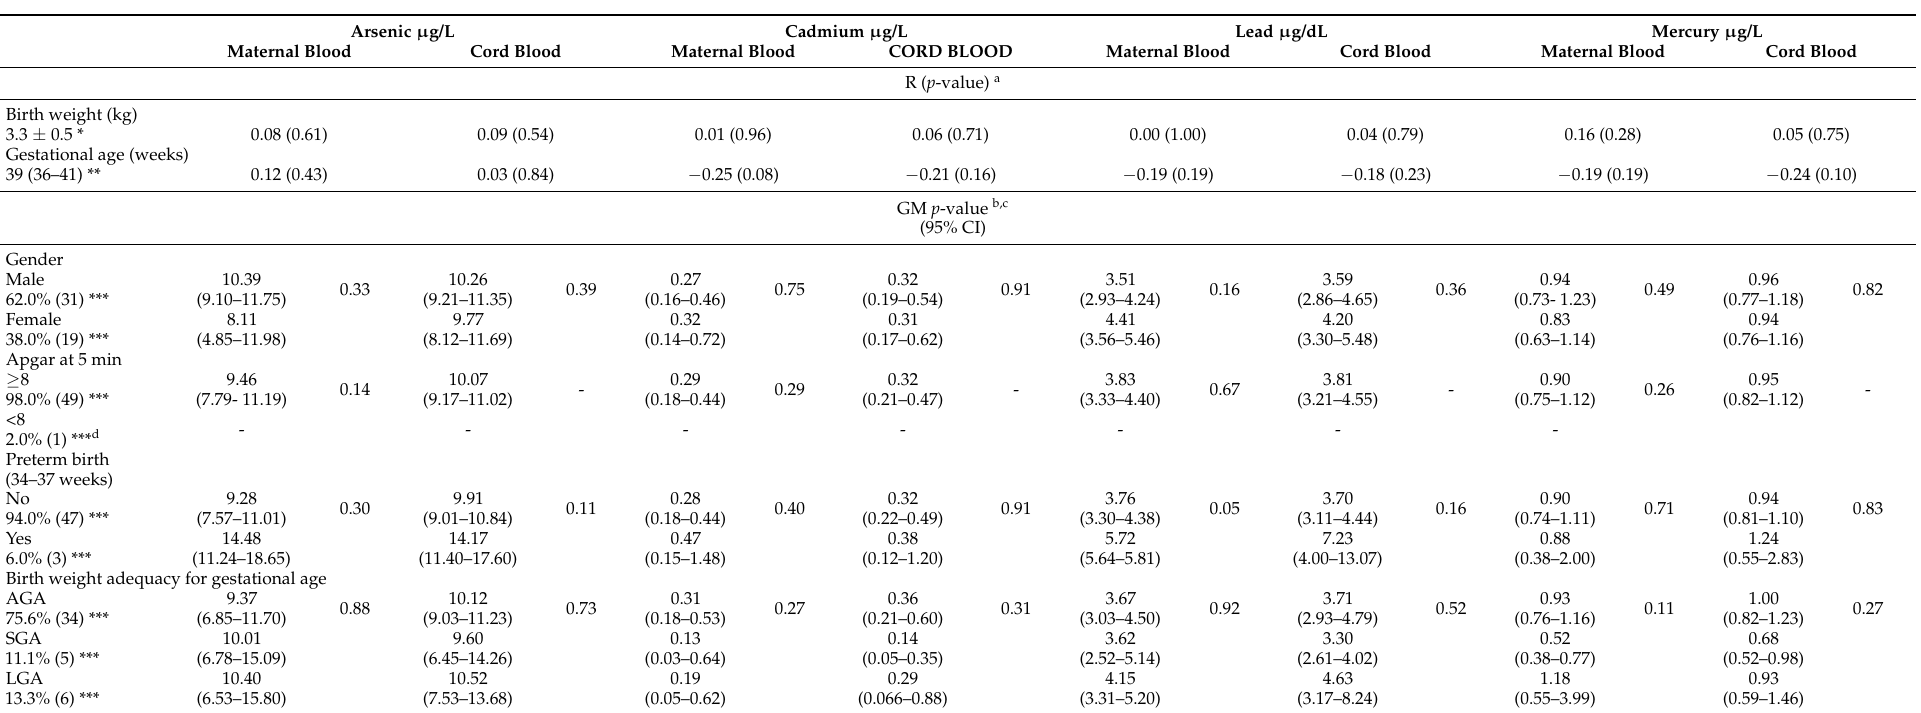
Table 3. Descriptive characteristics of birth outcomes and correlations with metal concentrations in maternal blood and umbilical cord blood, Rio de Janeiro, Brazil,